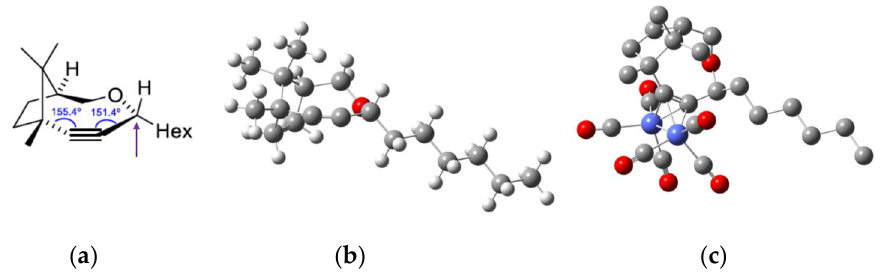
Figure 2. ( a ) Calculated angle-strain in cyclooctyne 1 ; ( b ) 3D ball-and-stick molecular model of minimized ( R )- 1 ; ( c ) 3D ball-and-stick molecular model of minimized ( R )- 15 (hydrogen atoms are omitted for clarity).